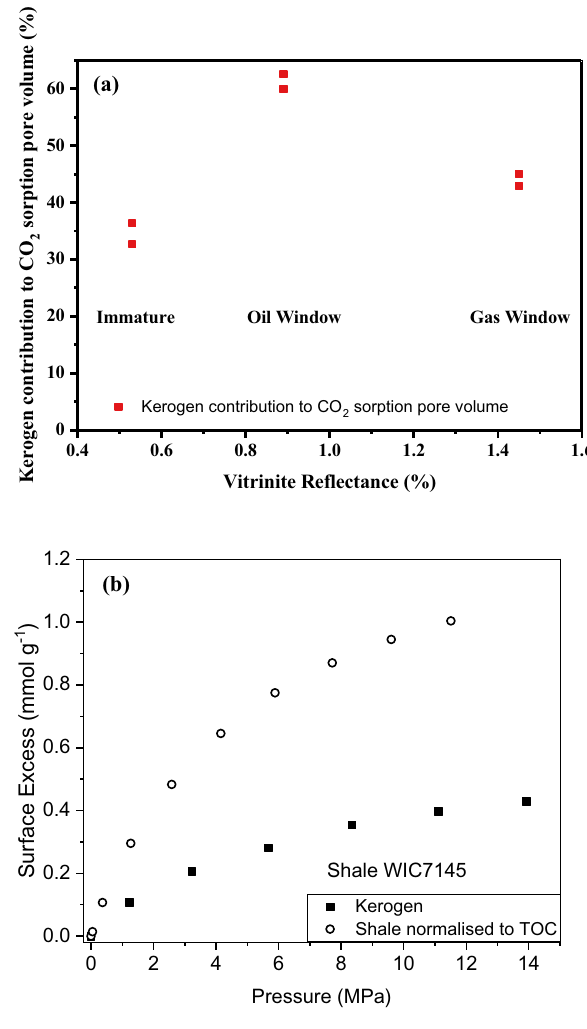
Fig. 14 Kerogen contributions to Posidonia shale adsorption a CO sorption pore volumes (195 K), b comparison of supercritical CH adsorption isotherms at 338 K for shale normalized to TOC with the isolated immature kerogen